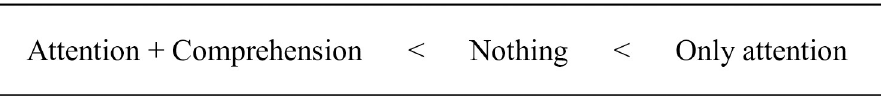
Fig 1. Prediction of frequency of somatic complaints among the three